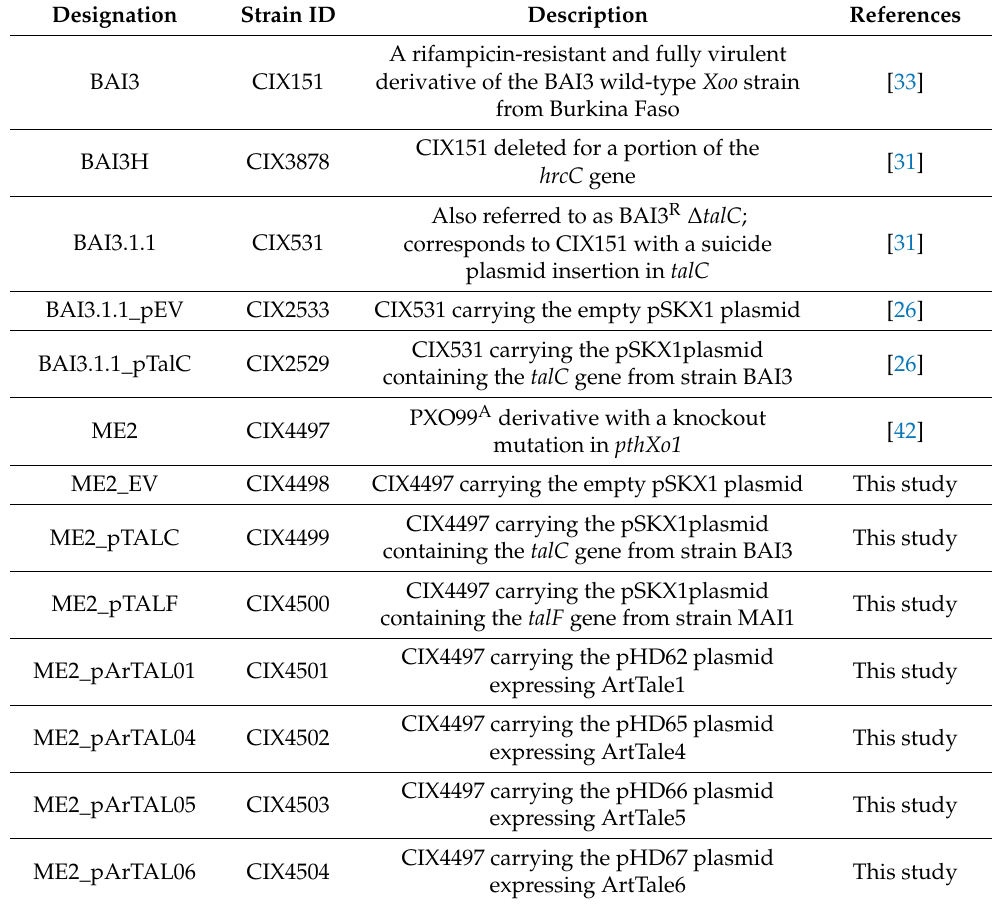
Table 2. List of X. oryzae strains used in this